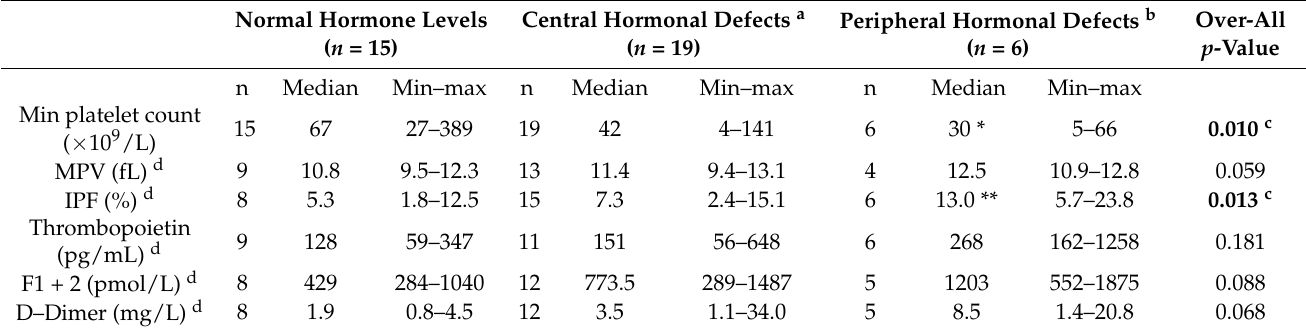
Table 4. Platelet count and markers of thrombopoiesis, thrombin formation and fibrinolysis during acute PUUV infection in patients with normal hormone levels, and in those with overt central or peripheral hormonal